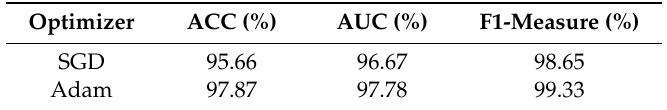
Table 4. Comparison of Adam and SGD using LiteNet for set A with the ten-fold cross-validation method.